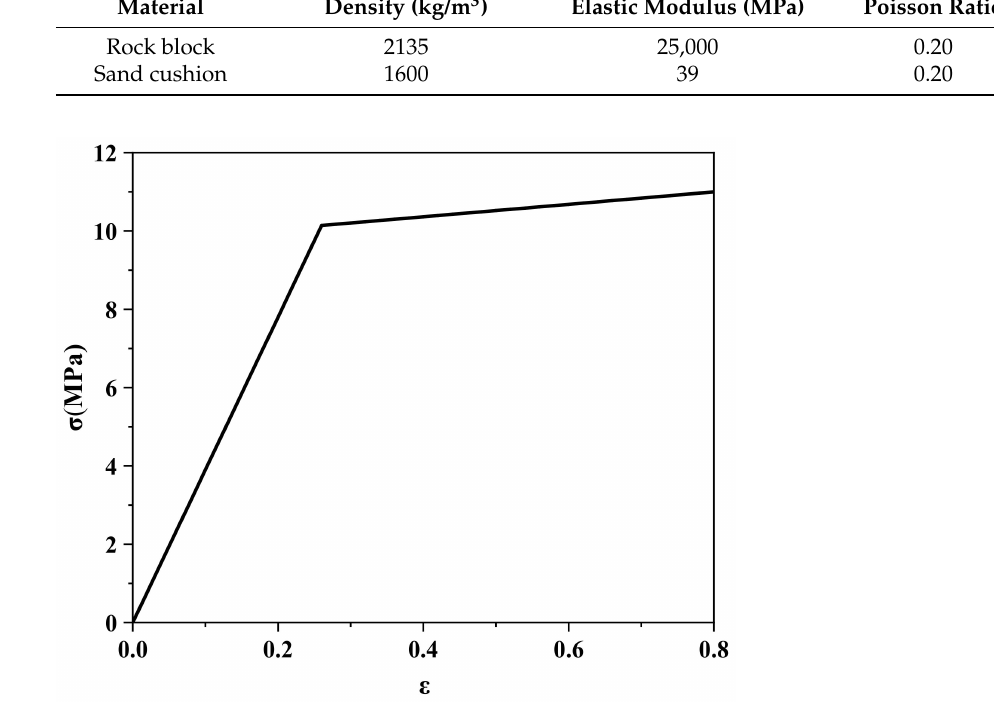
Figure 8. Constitutive model curve of the cushion